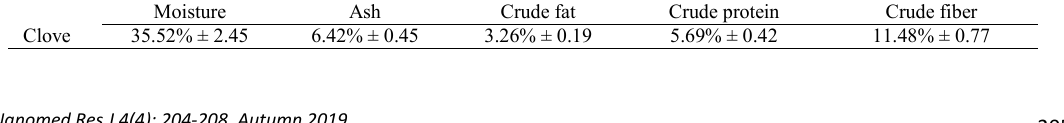
Table 1 . Proximate composition of clove